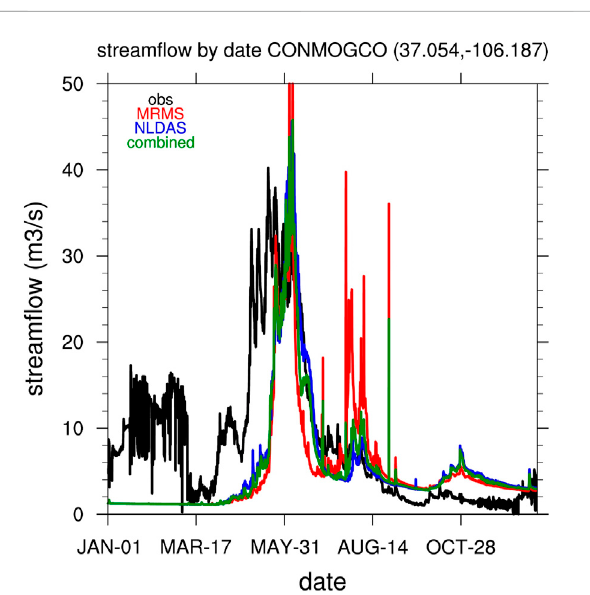
FIGURE 10 Colorado ESP domain terrain height (shading, m), Rio Grande basin boundary (thick black line), and USGS and Colorado Division of Water Resources gauges used as seasonal stream fl ow forecast points (red dots).